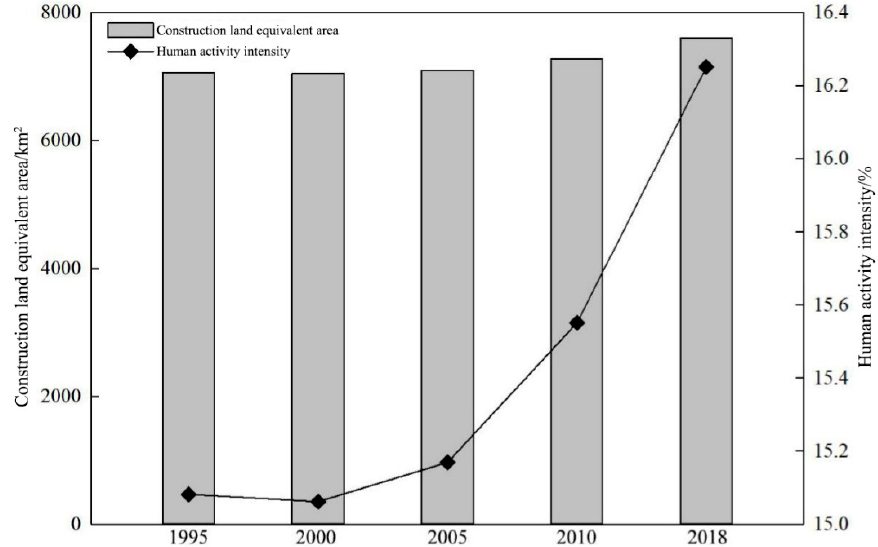
Figure 8. Equivalent area of construction land and intensity of human activities.